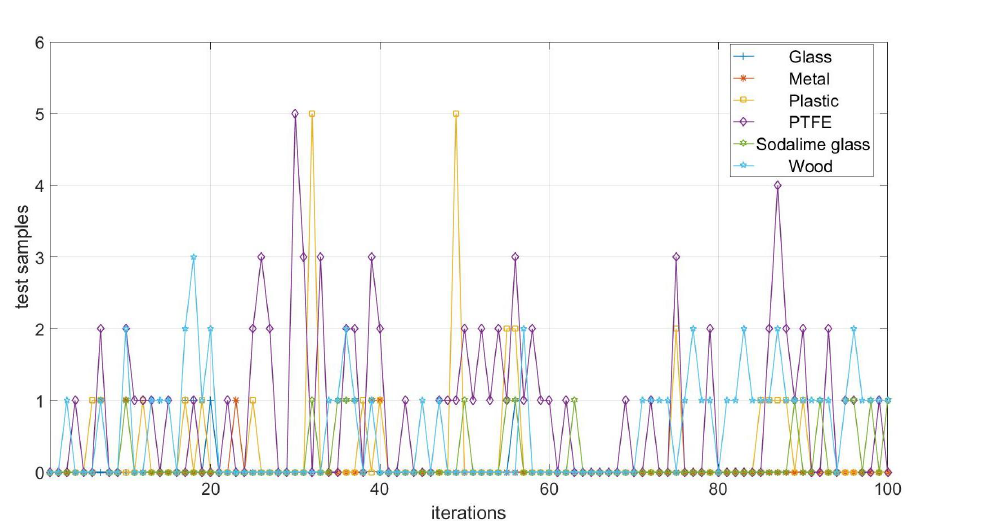
Figure 13. Confusion matrices obtained by the MLP classifier trained on the Complex nature dataset. Curve ( a ) shows the plot of the well-classified terms TP and TN, while curve ( b ) is the plot of the misclassified terms FP and FN.